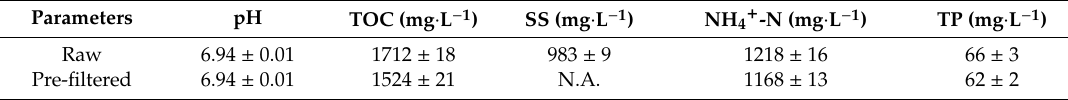
Table 1. Major water quality parameters of the toilet wastewater before / after